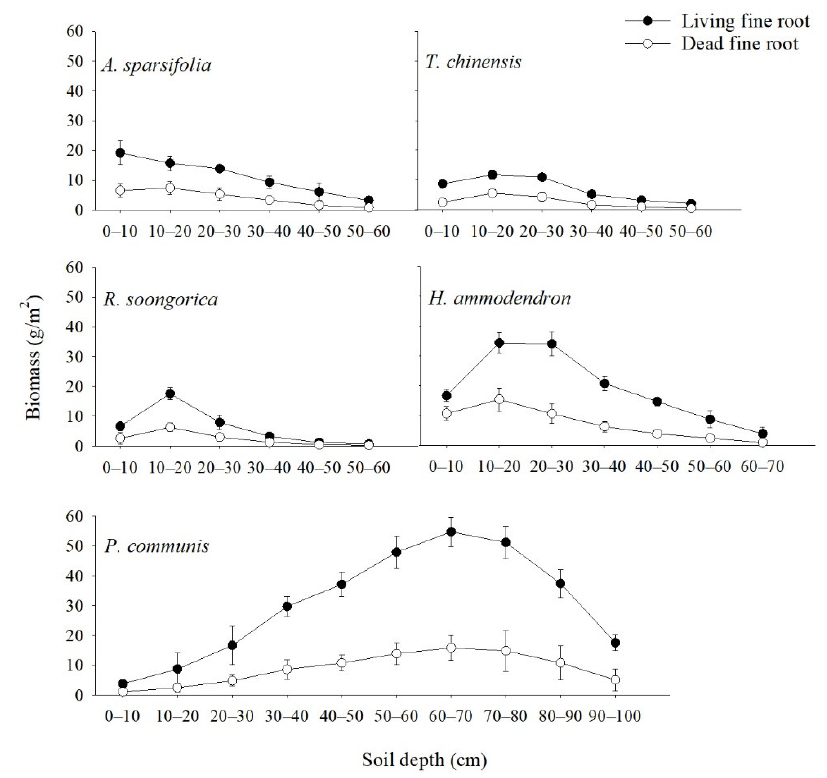
Figure 2. Living and dead fine root biomass (mean ± SD) of the five plant communities at different soil depths. Each value represents the average of three replicates.